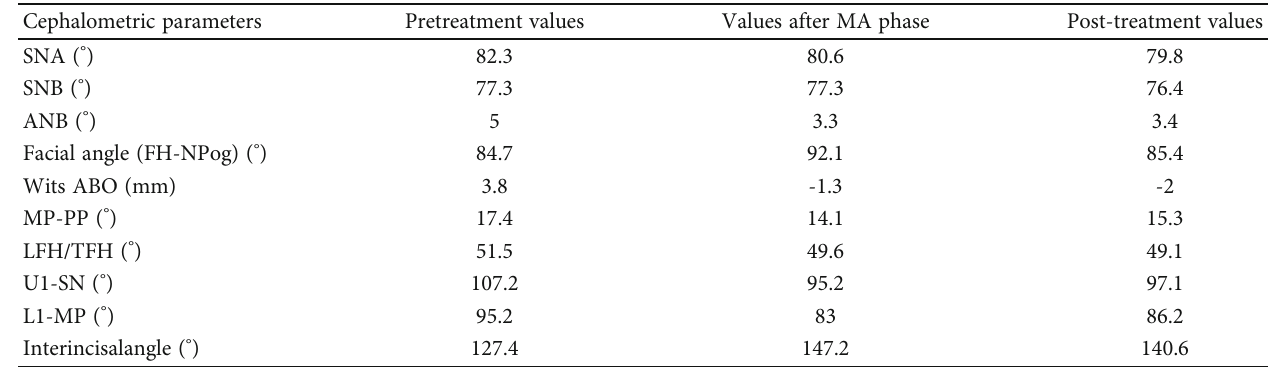
Figure 10: Superimposition on the FH plane pretreatment and post-treatment. Table 1: Comparative cephalometric